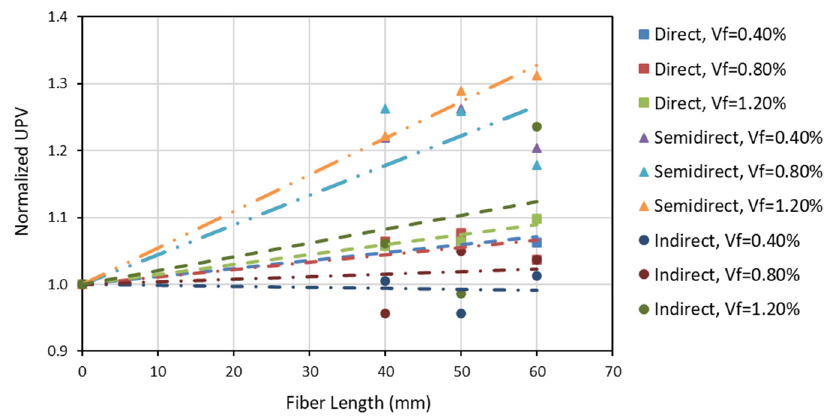
Figure 10. Correlation between the reinforcement index and ultrasonic pulse velocity.